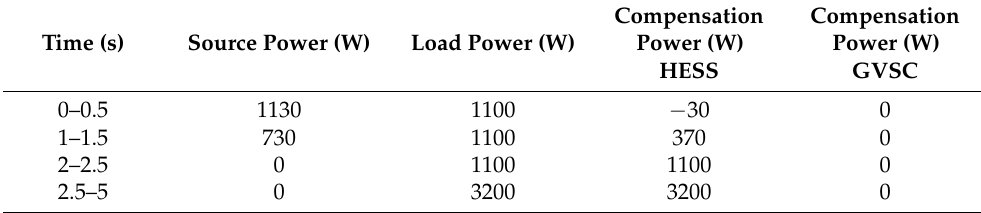
Table 2. Mode of operation